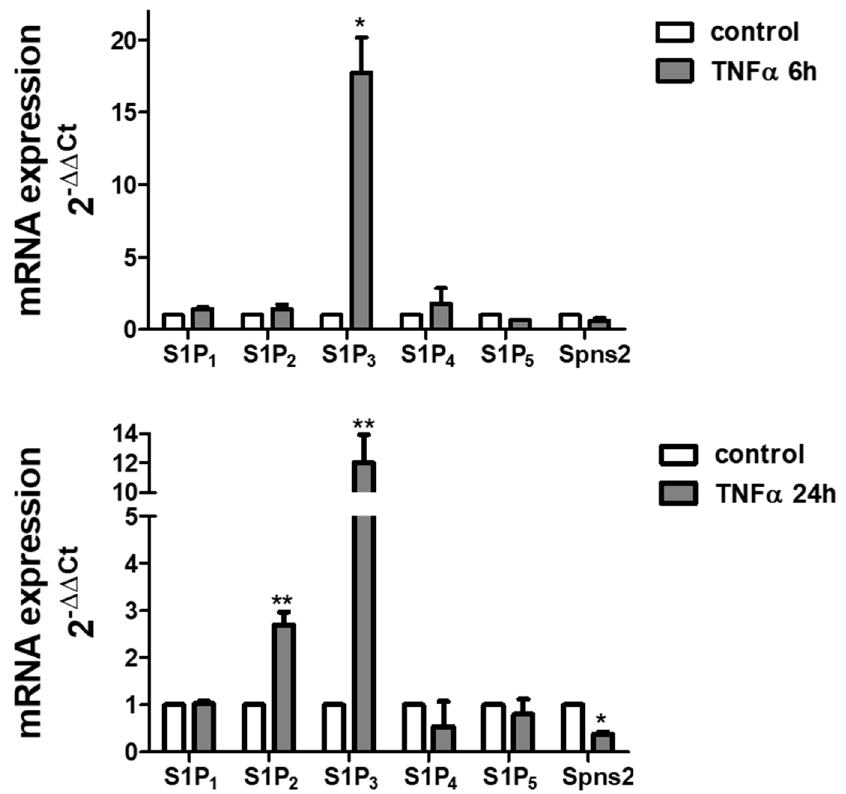
Figure 3. TNF α modulates S1P signalling. Quantitative mRNA analysis was performed by real-time PCR in total RNA extracted from C2C12 myotubes stimulated or not with 100 ng/mL TNF α for the indicated time intervals (6 h and 24 h). mRNA quantitation of S1PR (S1P 1 , S1P 2 , S1P 3 , S1P 4 and S1P 5 ) and S1P specific transporter, Spns2, was based on the 2 − ∆∆ Ct method, using individual enzyme or Spns2 of the unchallenged specimen as calibrator. Data are the mean ± SEM of three independent experiments performed in triplicate. The increase in S1P 2 and S1P 3 and the decrease in Spns2 expression induced by TNF α were statistically significant by Student’s t test (* p < 0.05; ** p < 0.01).